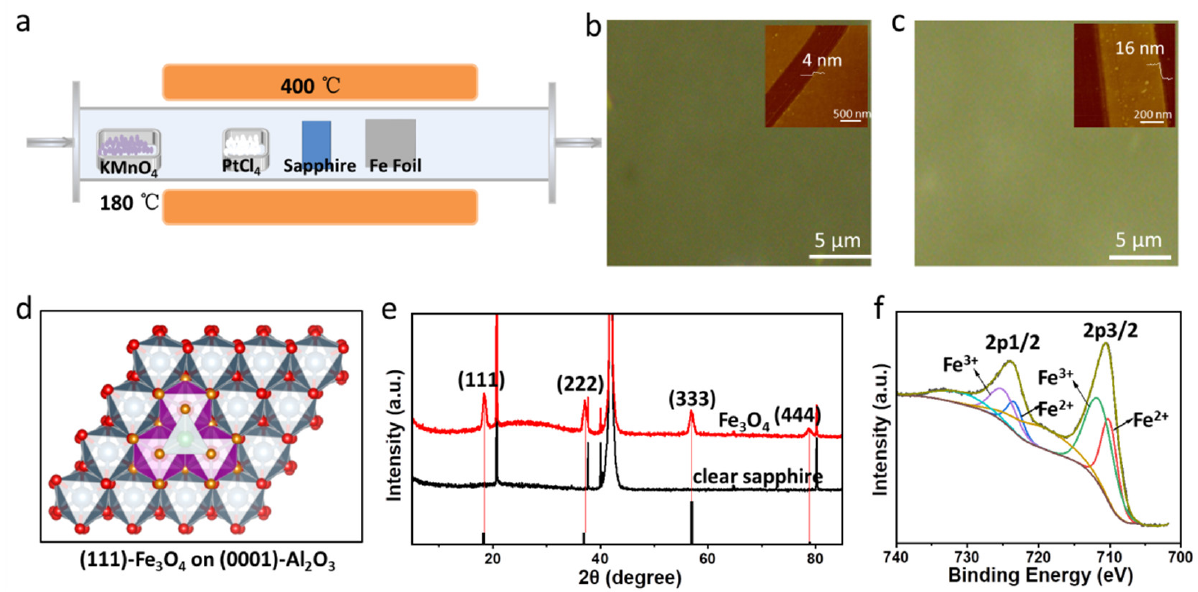
Figure 1. ( a ) Illustration of tube furnace for the growth of Fe 3 O 4 . Optical microscopic images of ( b ) 4 nm and ( c ) 16 nm Fe 3 O 4 films grown on sapphire; insets of ( b , c ) are the AFM images; ( d ) schematic diagram of (111) faced Fe 3 O 4 crystal structure on (0001) plane of Al 2 O 3 ; ( e ) XRD patterns of the Fe 3 O 4 film; ( f ) XPS spectra of Fe 3 O 4 film.